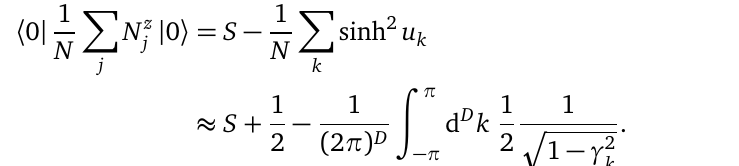
Table 4.1: The ground state energy density for the Heisenberg antiferromagnet on square and cubic lattices with z = 2 D . Indicated first for general spin, and then for the specific cases of S = 1 / 2 and S = 1, are the absolute energy per site as well as the relative energy gain with respect to the classical expectation value E / JN = − 1 / JN absolute relative S = 1 E 0 D = 2 − 2 S ( S + 0.1579 ) 15.8 / S % − 3 S ( S + 0.0972